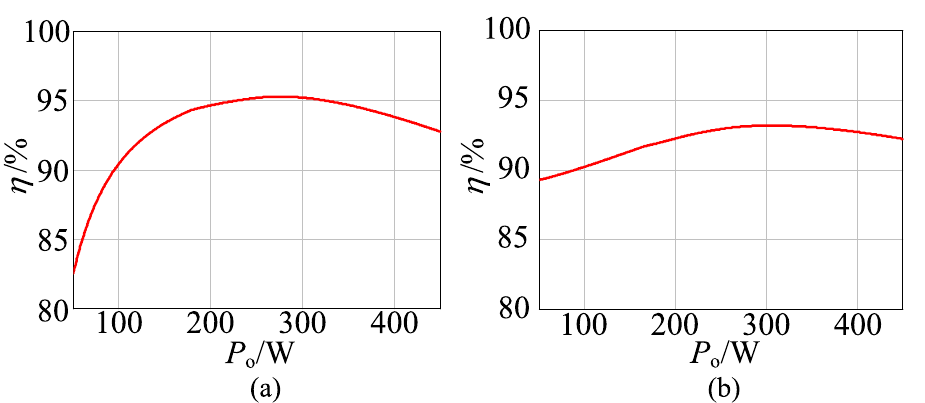
Figure 15. The calculation curve of the efficiency, ( a )step-up mode, ( b ) step-down